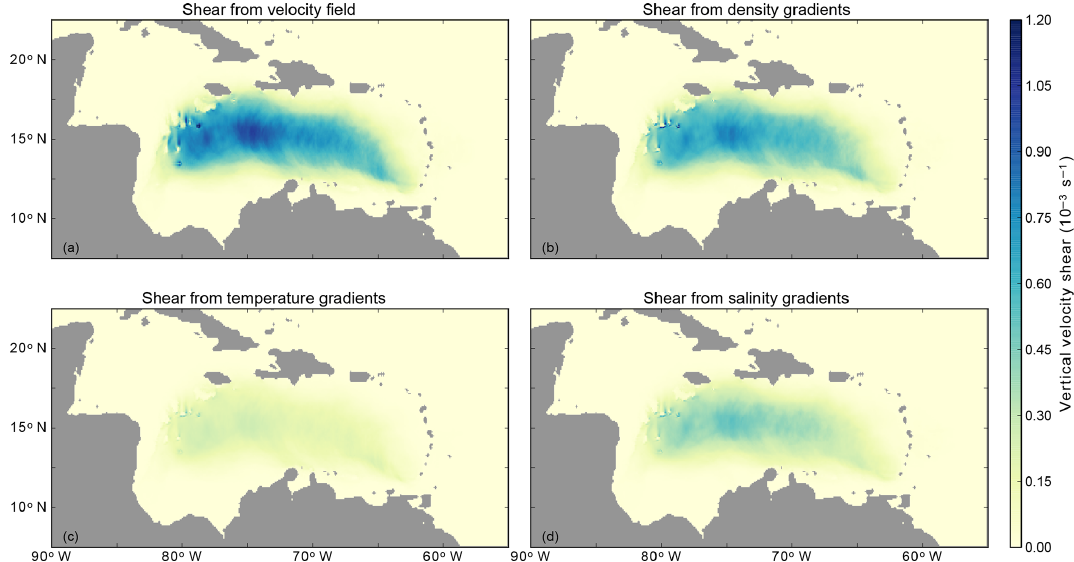
Figure 7. (a) Vertical shear of the anticyclones averaged over the upper 50m. (b) Horizontal density gradients of the anticyclones, scaled with g/(ρ 0 f ) according to the thermal wind equation. Horizontal density gradients due to (c) temperature gradients and (d) salinity gradients of the